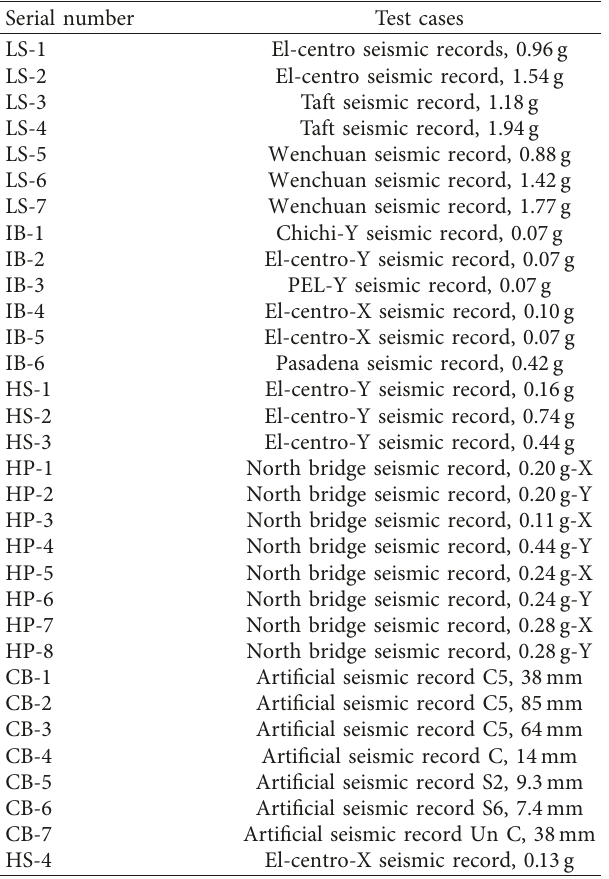
Table 4: Working cases with different earthquakes and structural